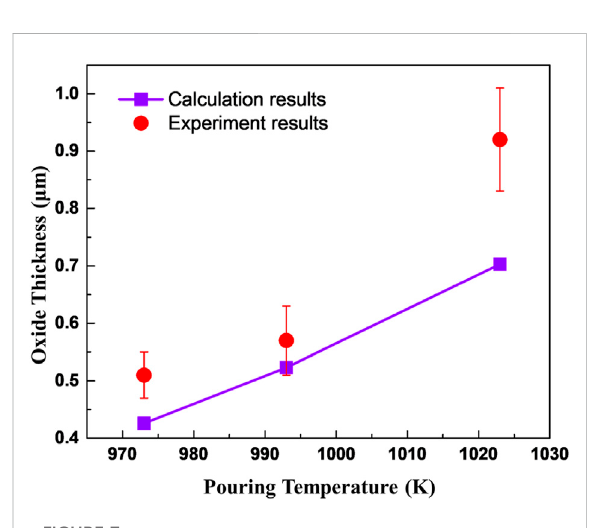
FIGURE 7 The thicknesses of oxide obtained through experiments and